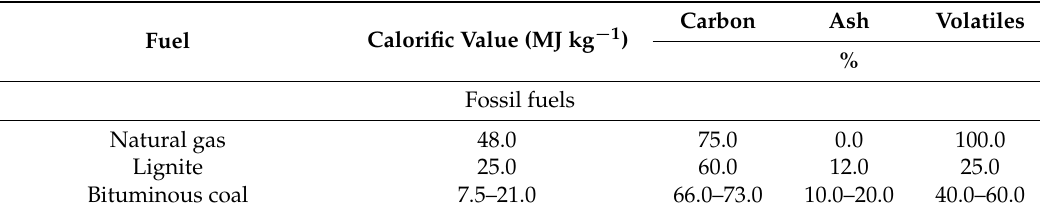
Table 4. The calorific value and contents of carbon, ash and volatiles in selected fuels and biochars